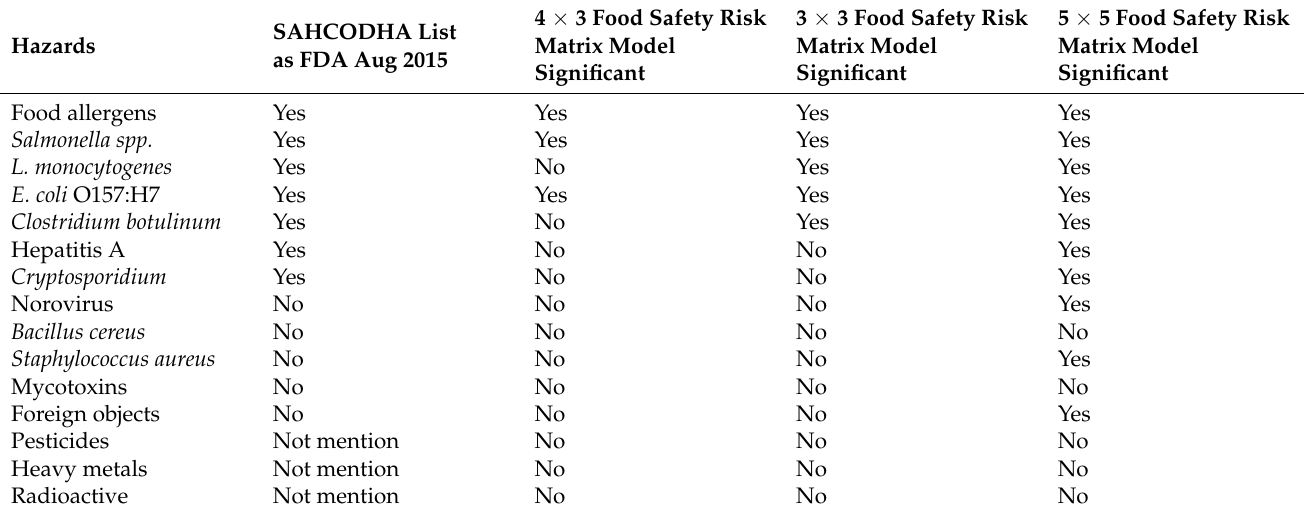
Table 6. Comparison of all significant hazards in each practical fruit and vegetable qualitative food safety risk matrix models with Tables 16 and 17 (FDA, 2015).